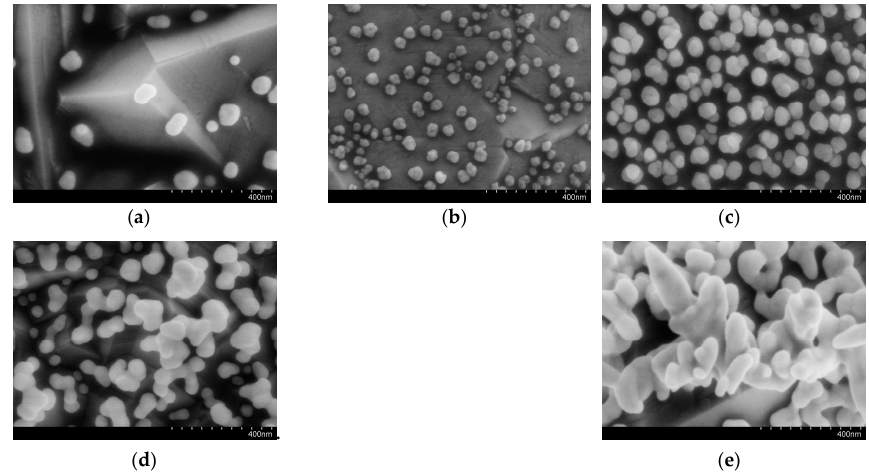
Figure 10. The SEM images of the AuNPs–BDD electrode with different deposition time ( a ) 100 s ( b ) 200 s ( c ) 300 s ( d ) 400 s ( e ) 500 s.